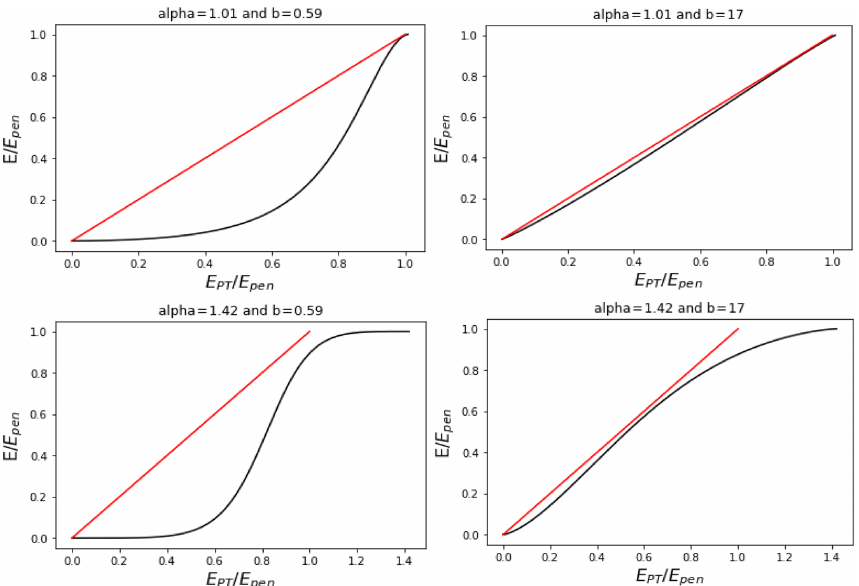
Figure 1. The sigmoid function (black curves) and the Priestley–Taylor line ( α = 1 . 26, straight line in red) for the most extreme parameter values documented in HT18. The scales of the horizontal axes